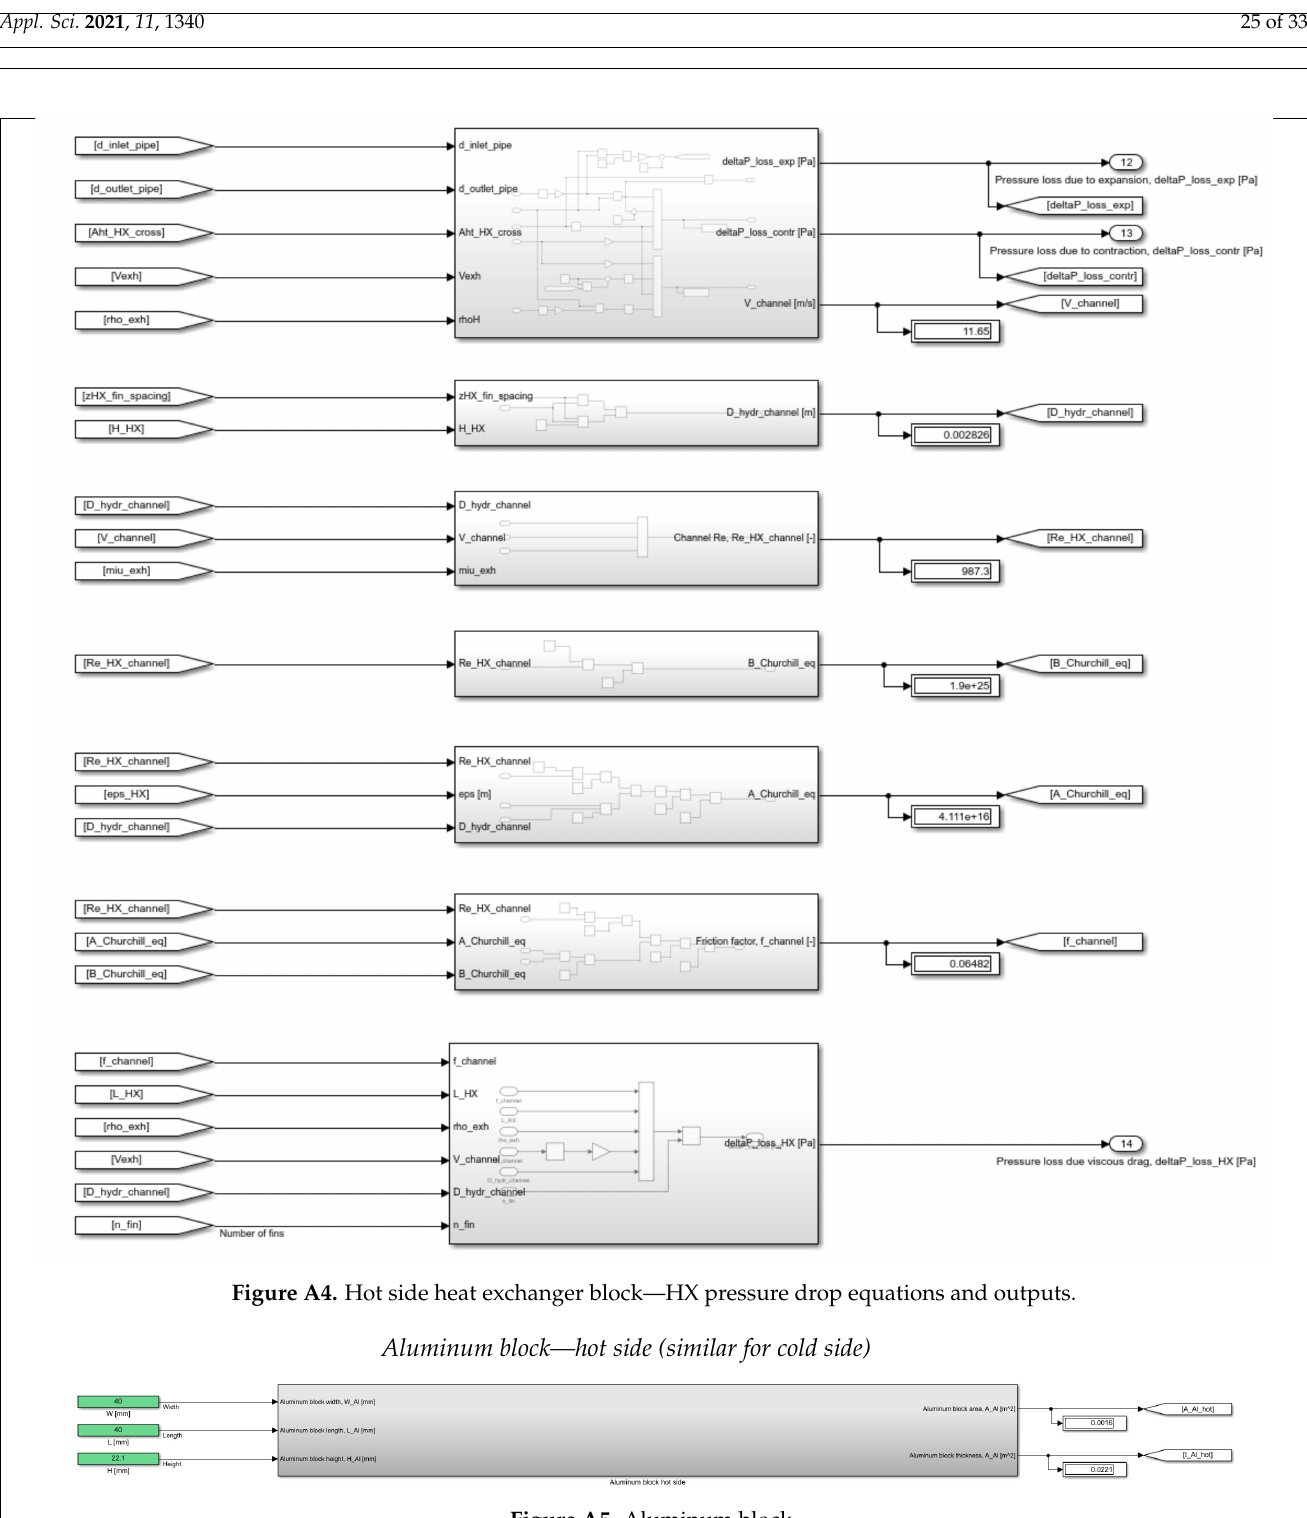
Figure A5. Aluminum block.